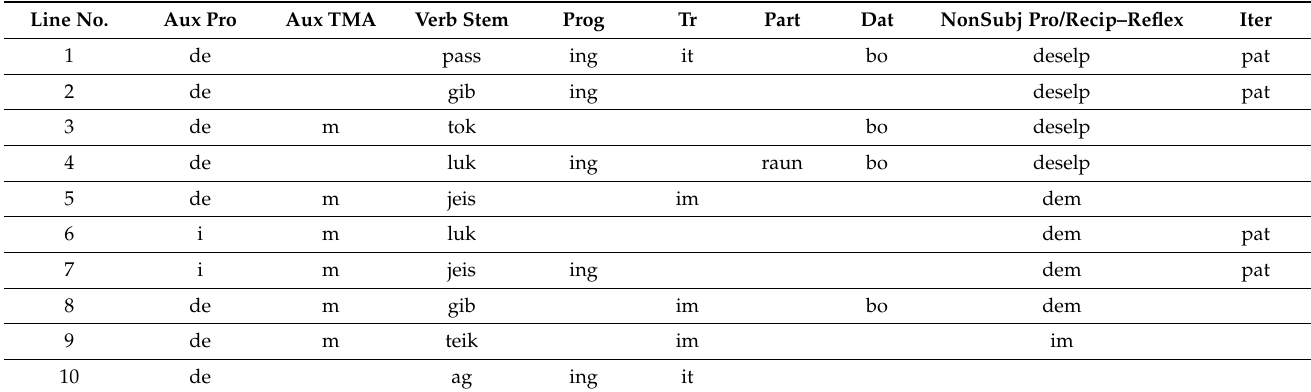
Table 8. Structure of Light Warlpiri